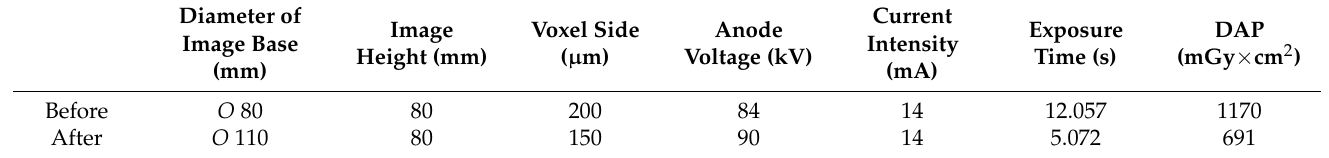
Figure 13. Example of an axial section ( a ) before and ( b ) after the optimization of the 3D CBCT imaging. Table 5. 3D CBCT setting before and after the optimization process.